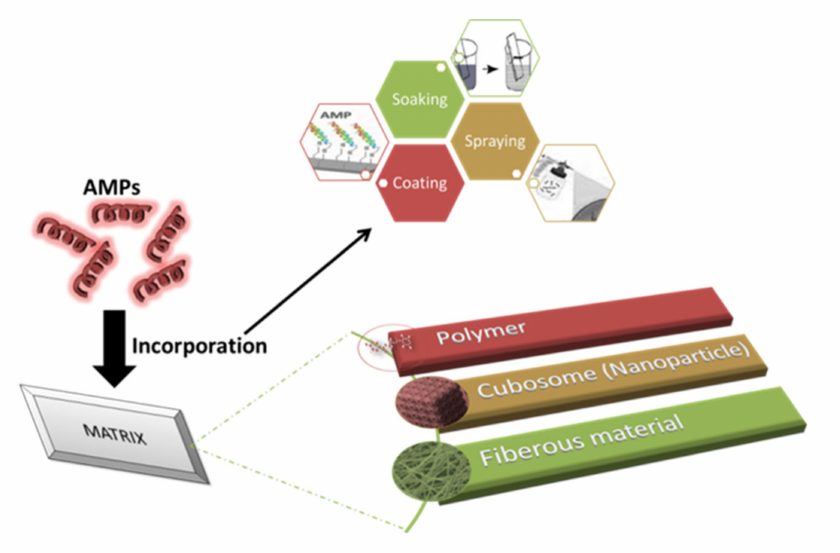
Figure 2. Impregnation of AMPs into compatible matrices. Incorporation of AMPs in a matrix is usually performed via soaking, coating, or spraying. The three common matrices are polymer, cubosome, and fibrous